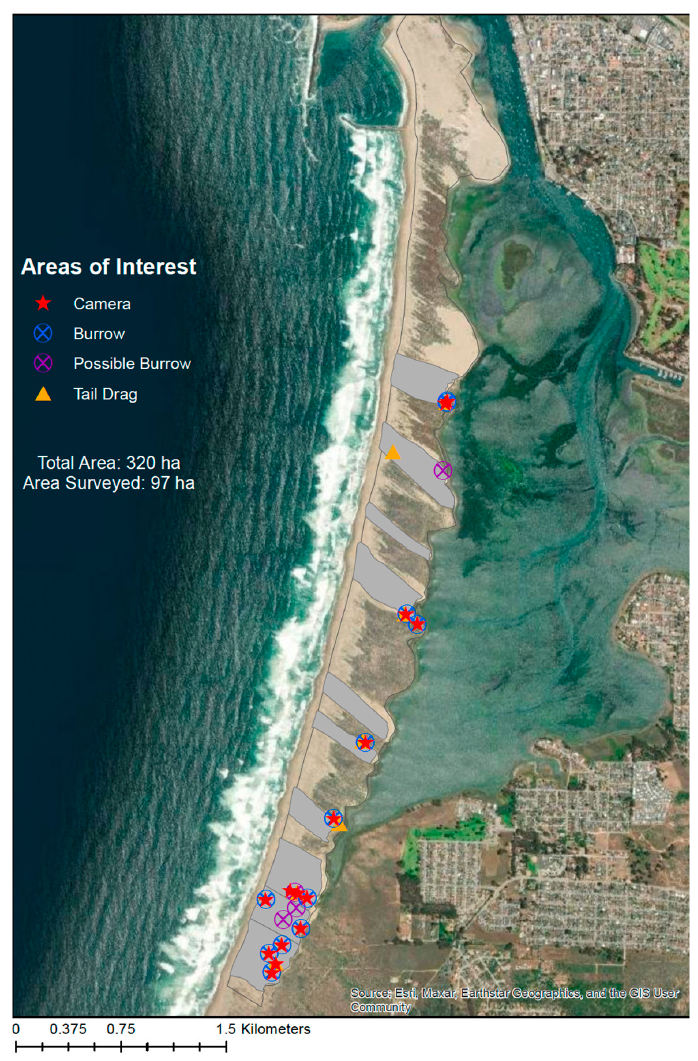
Figure 4. Areas of the Morro Bay sandspit covered through visual surveys for signs of MBKR (grey polygons) in Morro Bay, California. Areas of interest are the locations where possible signs were detected, and where cameras were